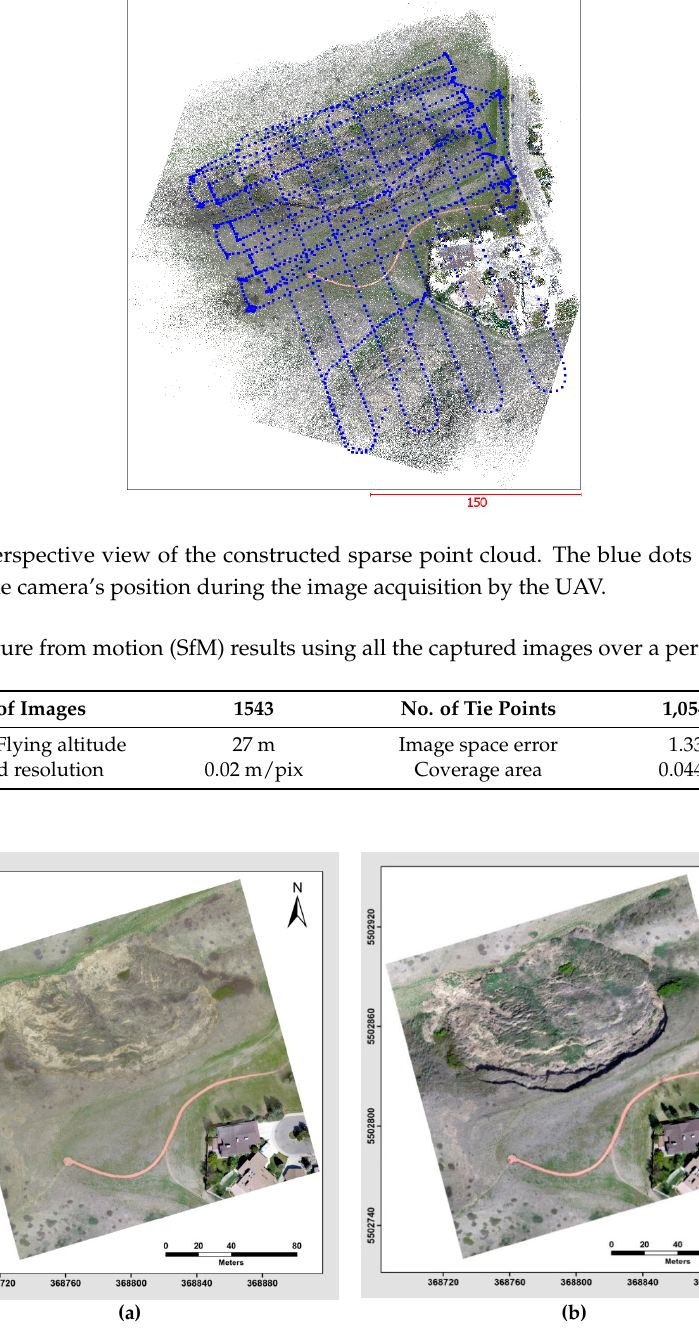
Figure 8. Perspective view of the colourized dense 3D UAV image-based point cloud